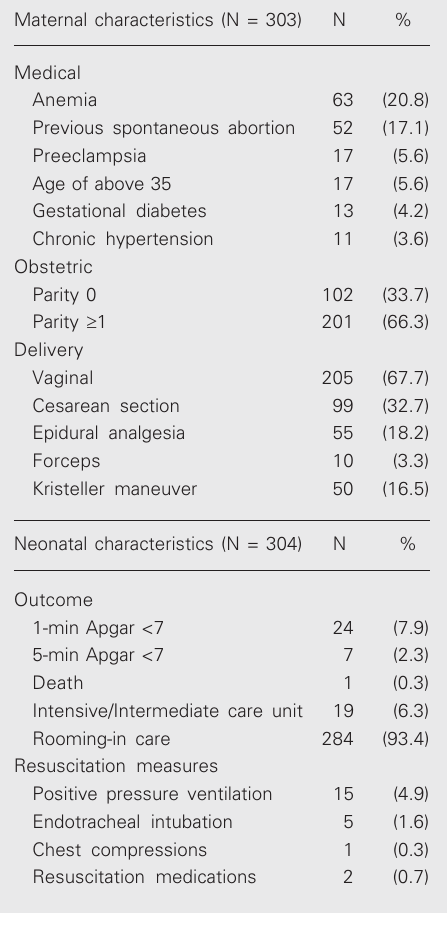
Table 4. Characteristics of the study sample.